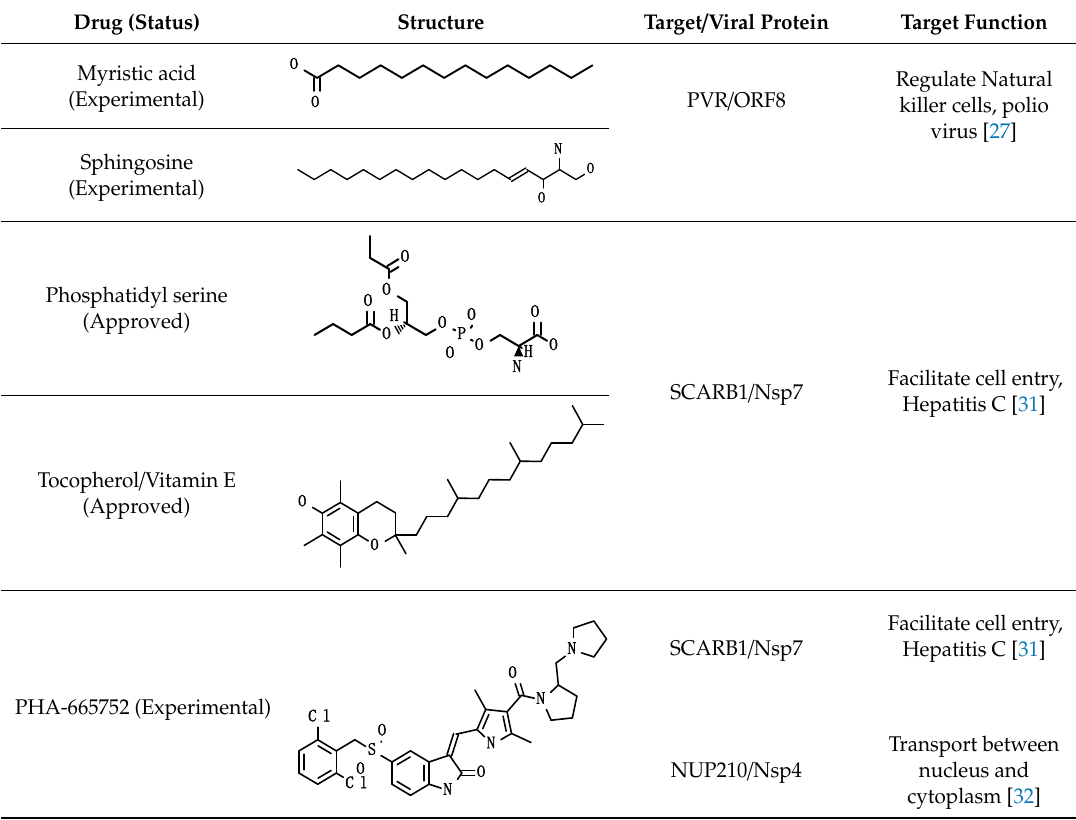
Table 6. Status and structure of drugs known to target controllability predicted proteins. Each target’s SARS-CoV-2 protein interactor is given along with its known target function.